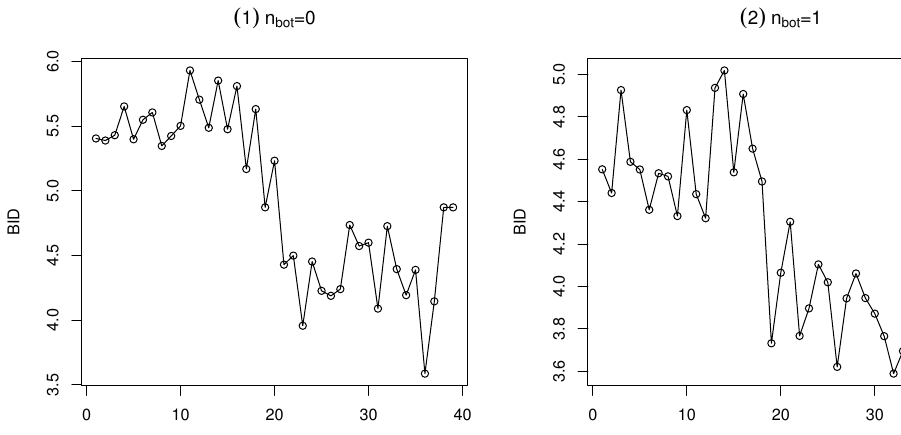
Figure 7. Plots of BID for n top = 10 with c = 0.01.